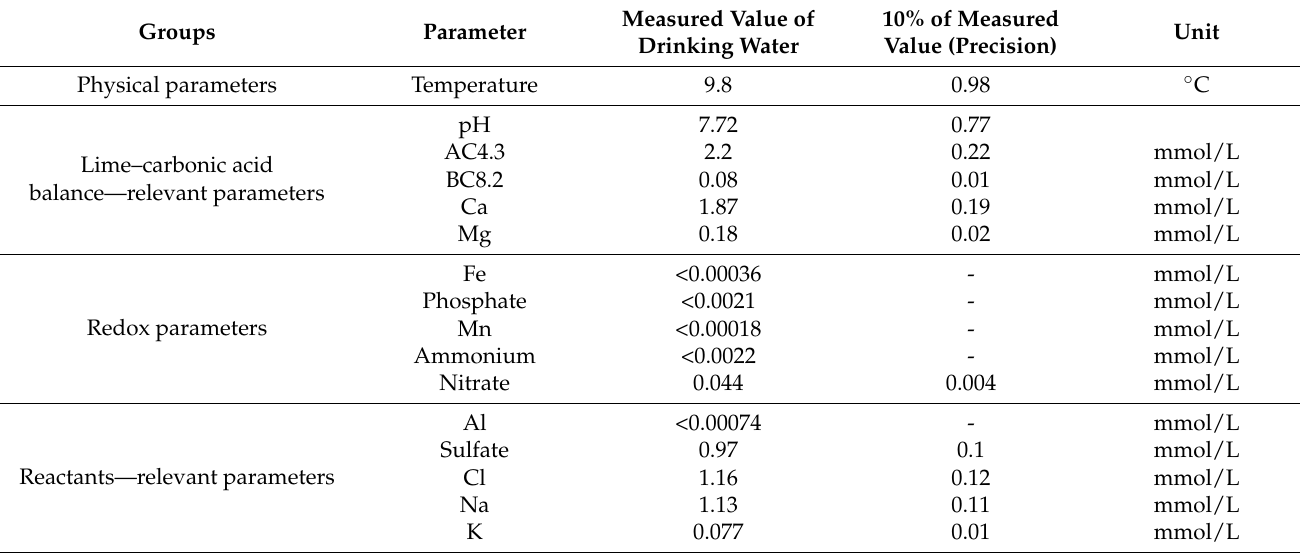
Table 2. Process characteristic value (precision) in 10% of the measured value of the parameters relevant to drinking water